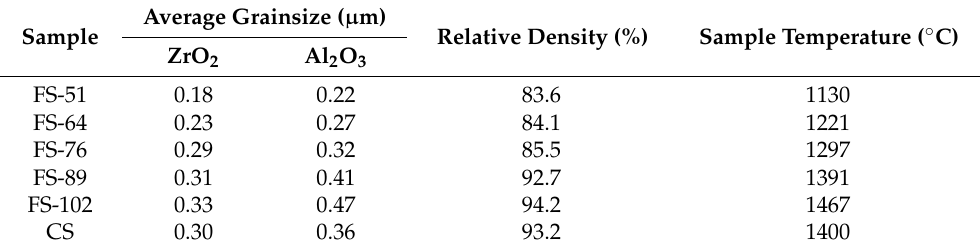
Table 1. The relative density, average grain size, and estimated sample temperature of 3YSZ/Al 2 O 3 composites under different sintering conditions. Average Grainsize ( µ Sample